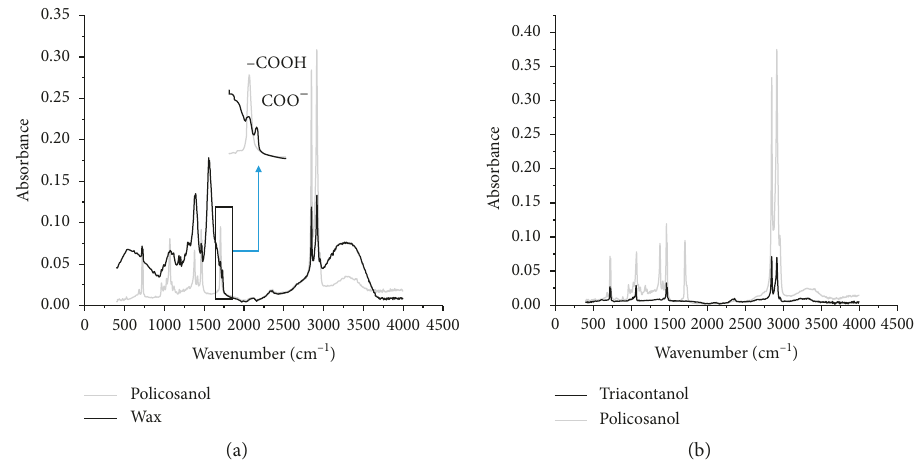
Figure 1: FTIR spectra of (a) policosanol and cochineal wax and (b) policosanol and triacontanol standard. Table 1: Composition and quantification of policosanol in g/kg of cochineal wax obtained by chemical hydrolysis methods. Policosanol composition Policosanol yield (%) Policosanol purity (%) Triacontanol Octacosanol